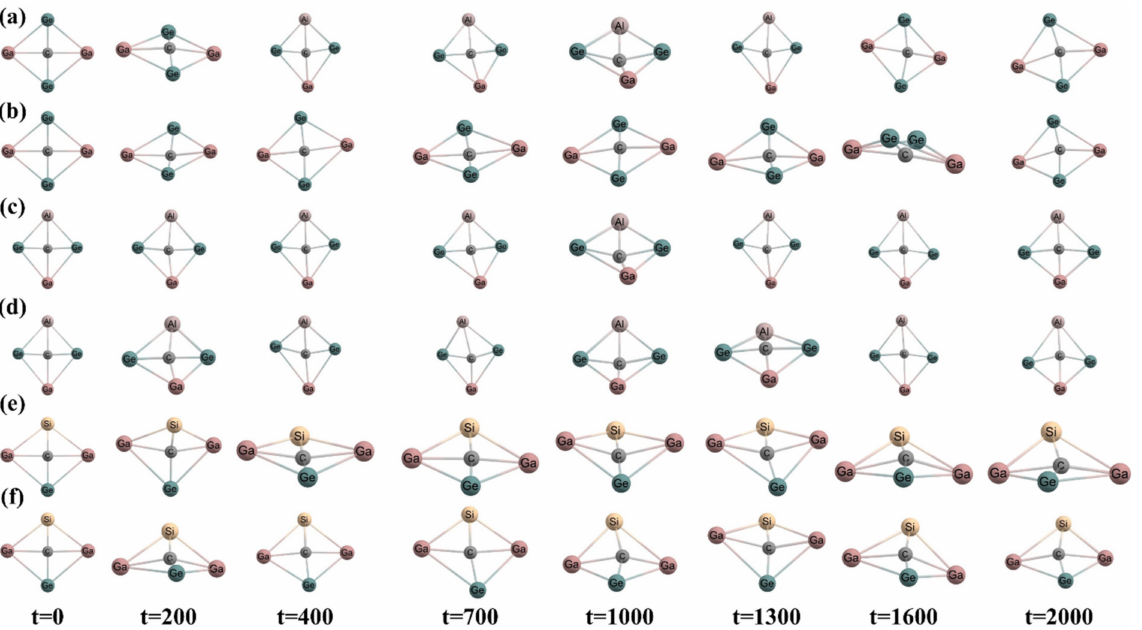
Figure 4. Snapshots at different time steps (time in fs) ( a , c , e ) at 300 K temperature and ( b , d , f ) at 500 K temperature of CGa 2 Ge 2 , CAlGaGe 2 , and CSiGa 2 Ge systems, respectively, in trans